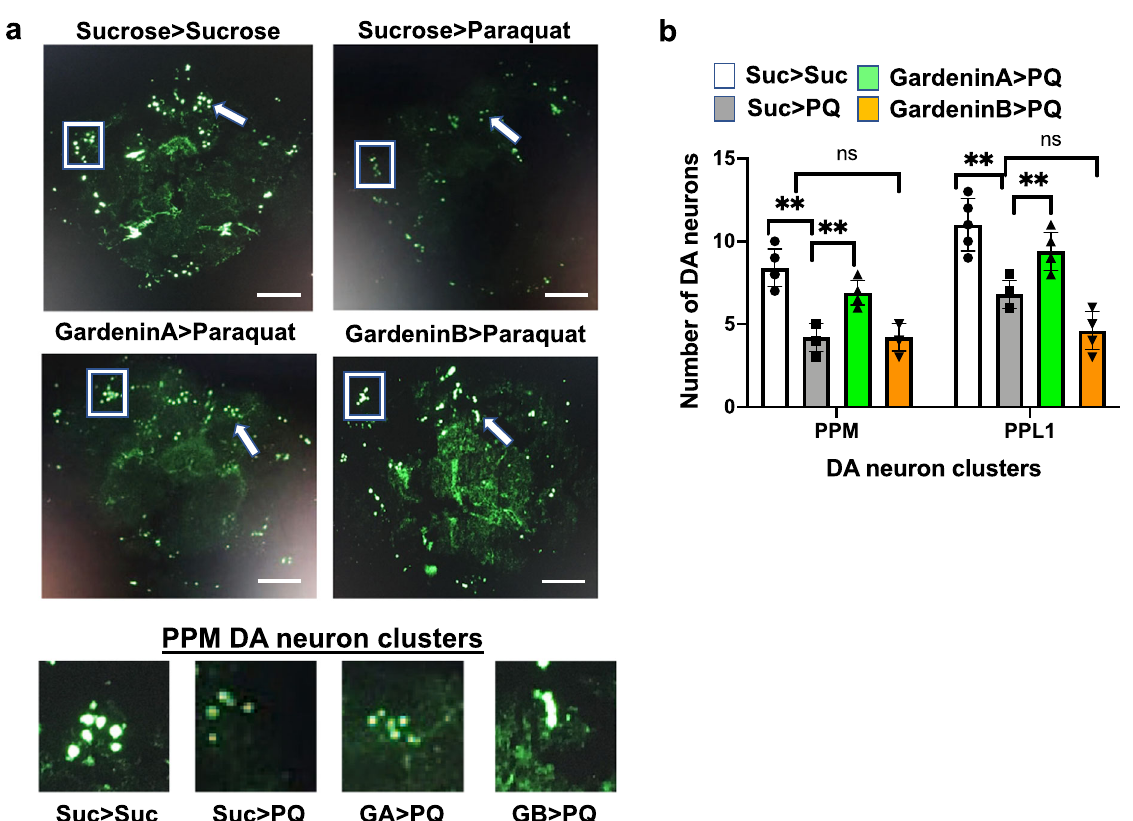
Fig. 2 GardeninA but not GardeninB is protective against PQ-mediated loss of dopaminergic neurons. a Confocal imaging was used to detect speci fi c clusters of dopaminergic neurons in response to the indicated feeding conditions. Adult male fl ies were either pre-fed for 4 days with 2.5% sucrose or GardeninA or Gardenin B (10 μ M) followed by continuous exposure to 5 mM PQ for 48 h (white bar: Suc>Suc, gray bar: Suc>PQ, green bar: GardeninA>PQ, orange bar: GardeninB>PQ). The speci fi c DA neuron clusters in the Drosophila brain are depicted by the GFP-positive green signals. White boxes indicate the DA neuron protocerebral posterior lateral 1 (PPL1) cluster and the white arrow specify the protocerebral posterior medial (PPM) DA neuron cluster. Scale bars 100 μ m. The bottom panel shows the enlarged representative views of the PPM DA clusters in response to the speci fi ed feeding conditions. b The average number of dopaminergic neurons per cluster (PPM and PPL1) in response to the indicated feeding conditions are plotted. Data are representative of at least fi ve independent biological replicates. Data shown represent mean ± SEM. ** p < 0.01; ns not signi fi cant based on one-way ANOVA between different feeding